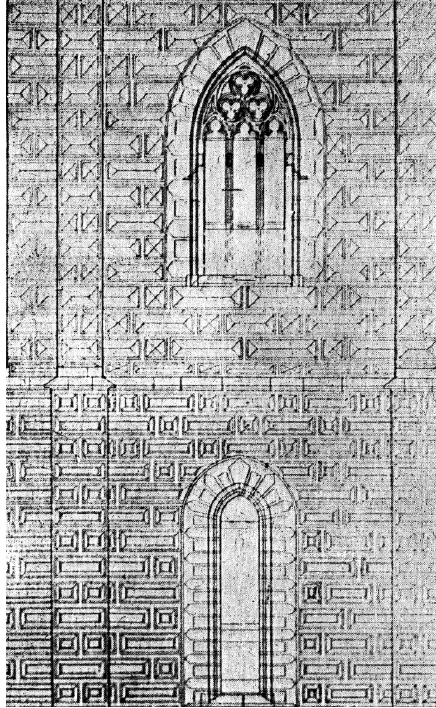
Figure 11. Sgraffito decoration on one of the towers of St. Mary Magdalene in Wrocław. Reconstruction on the basis of sgraffito remains, L. Burgemaister, 1911. Source: Burgemester (1911, p.